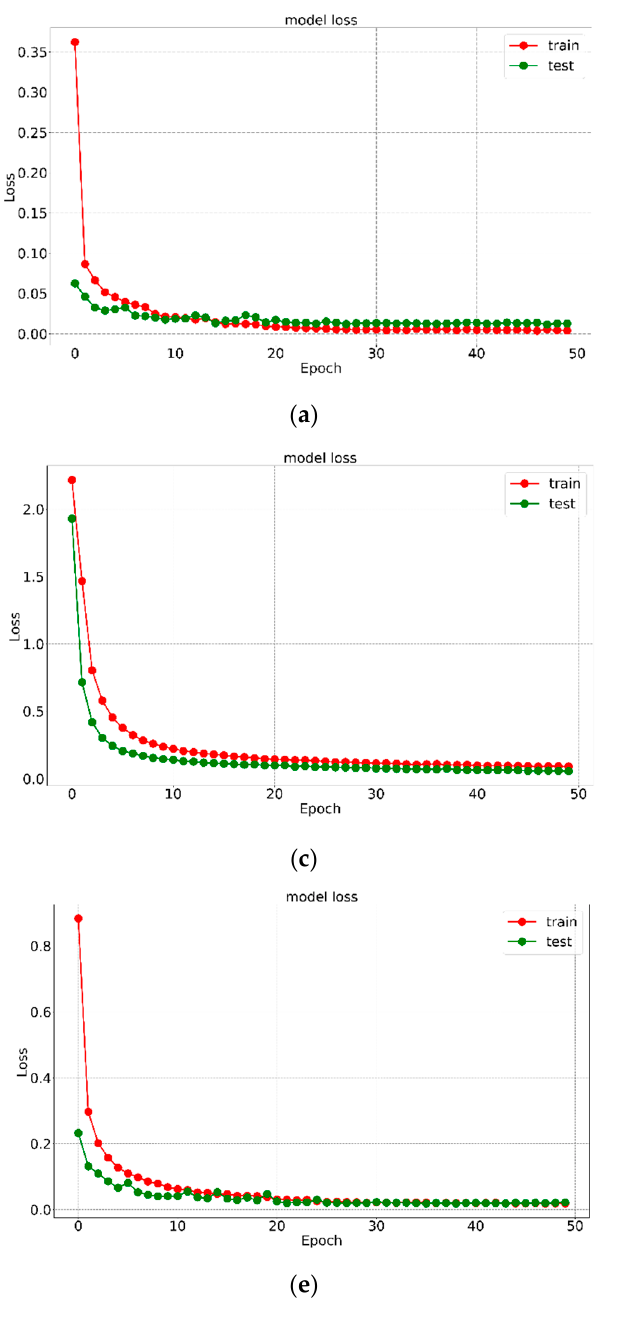
Figure 11. Validation loss of the proposed six models for digit (0–9) recognition. ( a ) Optimizer—‘ADAM’; learning rate—0.001. ( b ) Optimizer—‘ADAM’; learning rate—0.0001. ( c ) Optimizer—‘ADAM’; learning rate—0.00001. ( d ) Optimizer—‘RMSprop’; learning rate—0.001. ( e ) Optimizer—‘RMSprop’; learning rate—0.0001. ( f ) Optimizer—‘RMSprop’; learning rate—0.00001.